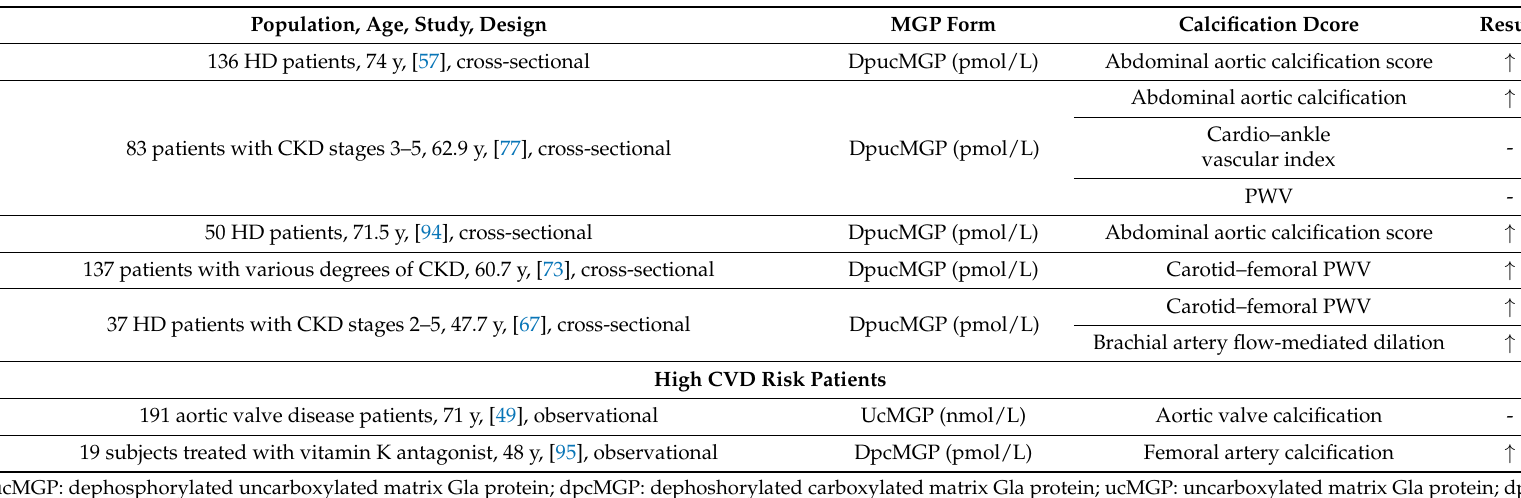
Population, Age, Study, Design MGP Form 136 HD patients, 74 y, [57], cross-sectional